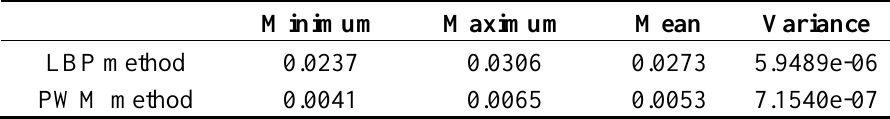
Table 2. The statistical data of EER by random sampling.